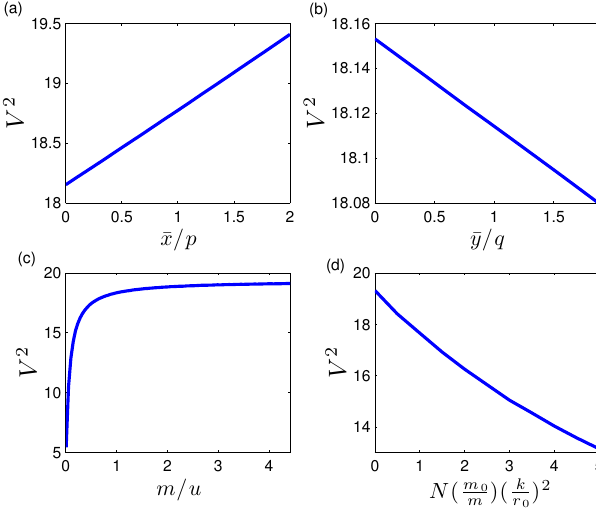
Figure 4. Comparison of the analytical solutions (solid line) for the inclined, curved, and horizontal sections of the track with the numerical simulation (dashed line). Table 2. Parameters used for the analysis of a prototypical pinewood derby car.